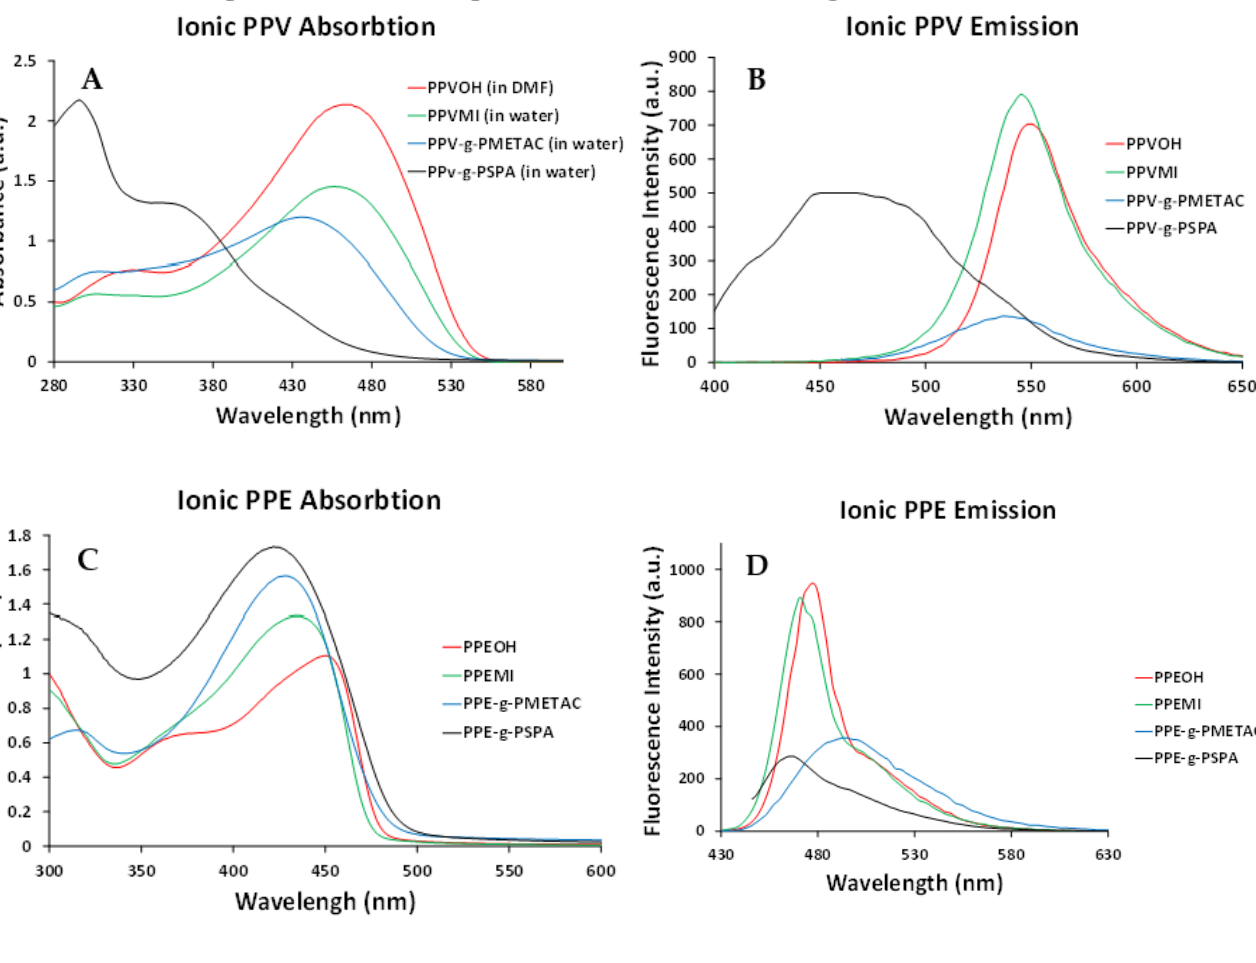
Figure 4. Absorption and emission spectra for ionic PPVs ( A , B ) and ionic PPEs ( C , D ) with ionic polymers in water and the backbone in DMF.